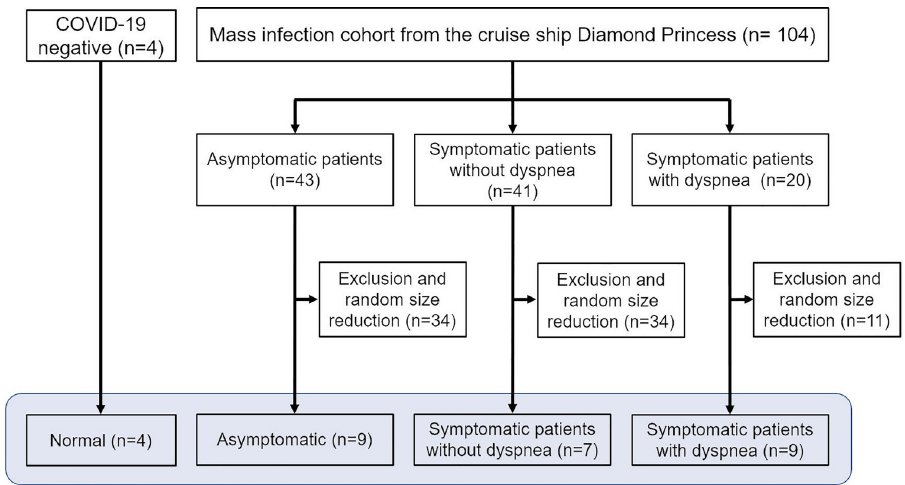
Fig 1. Schematic diagram of the COVID-19 CT data collection for FAN flow modeling